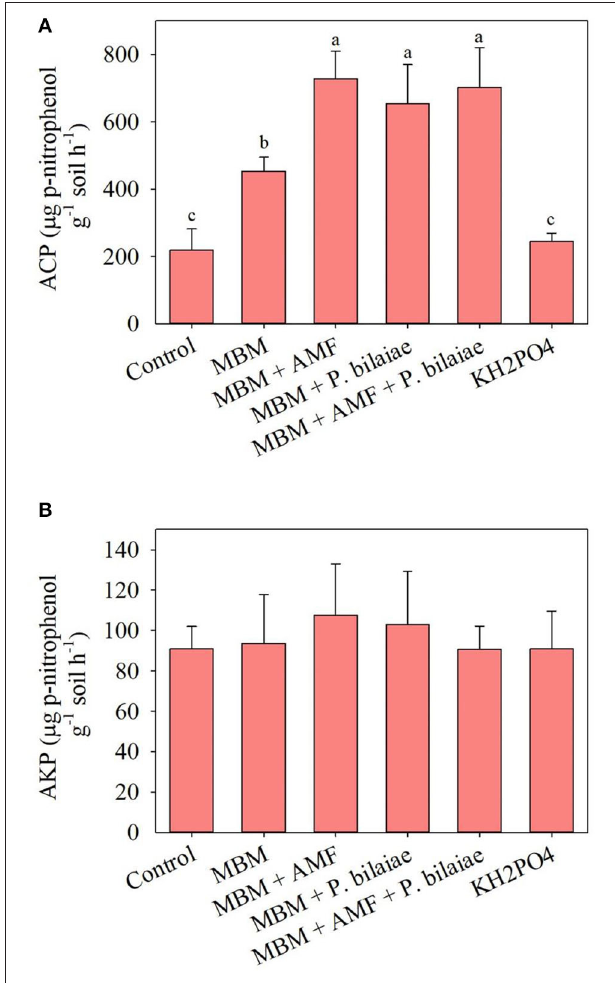
FIGURE 8 | Soil potential acid (A) and alkaline (B) phosphomonoesterase activity as affected by different P fertilizers and P mobilizers (arbuscular mycorrhizae fungi (AMF) and P. bilaiae ) at 40 days after planting. Different alphabetical letters signify the statistical difference (Tukey test, p < 0.05) across the treatments. Error bar represents the mean ± SD ( n =